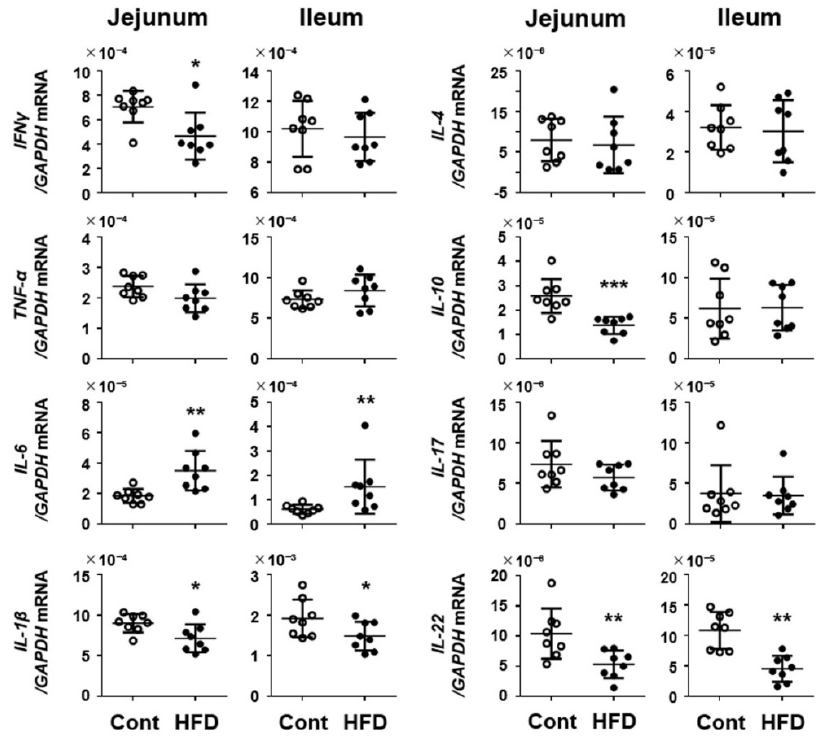
Figure 6. Effect of a HFD on mRNA expression of cytokines in mouse small-intestinal tissues. Results are expressed as the mean ± SD. * p < 0.05; ** p < 0.01 vs. control group. Cont, control ( n = 8); HFD, high-fat diet ( n = 8).